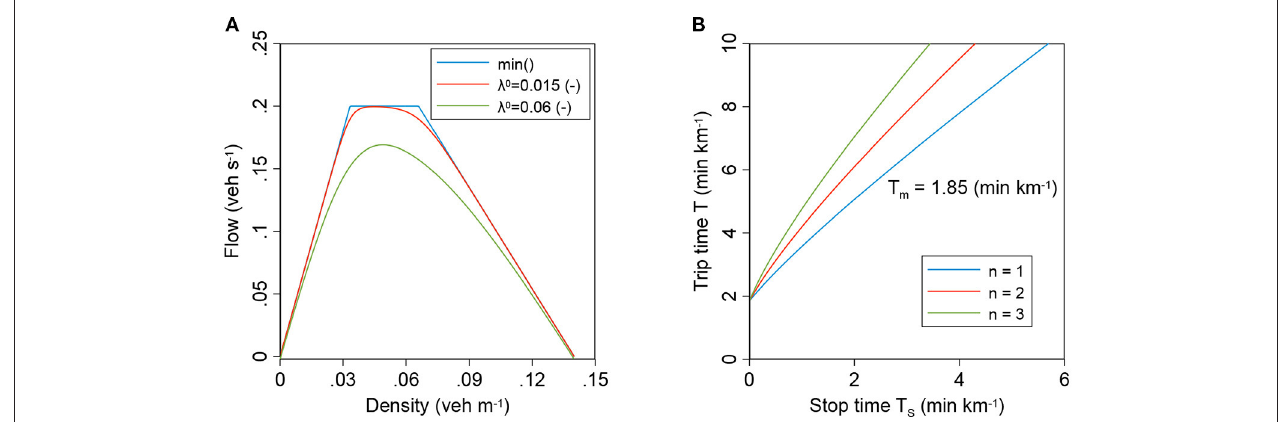
FIGURE 1 | Fundamental relationships of urban-scale traffic. (A) Illustrates the λ -MFD function with a trapezoidal uMFD from Equation (1). The uMFD is shown by the min() operator. The larger λ 0 becomes, the larger the distance between the observed or realized MFD and the uMFD, indicating a reduction in network performance; (B) the fundamental relationship of the two-fluid theory of urban traffic. The parameter n can be seen as a quality of service indicator of the road network and T m is the minimum travel time in the network per unit distance.